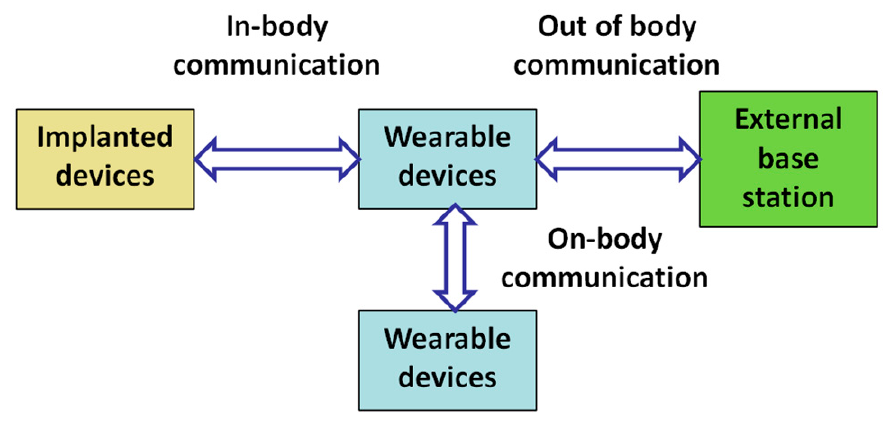
Figure 1. The system for collecting and transmitting information about the state of the human body. The system includes implanted and wearable devices and an external base station receiving collected information.